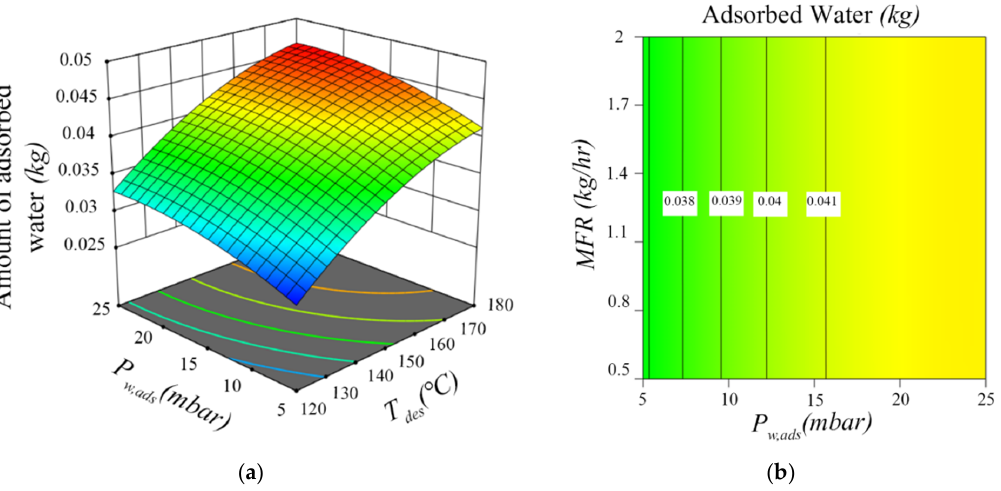
Figure 9. Amount of adsorbed water under different ( a ) desorption temperatures and partial pres- sures ( b ) mass flow rates and partial pressures.